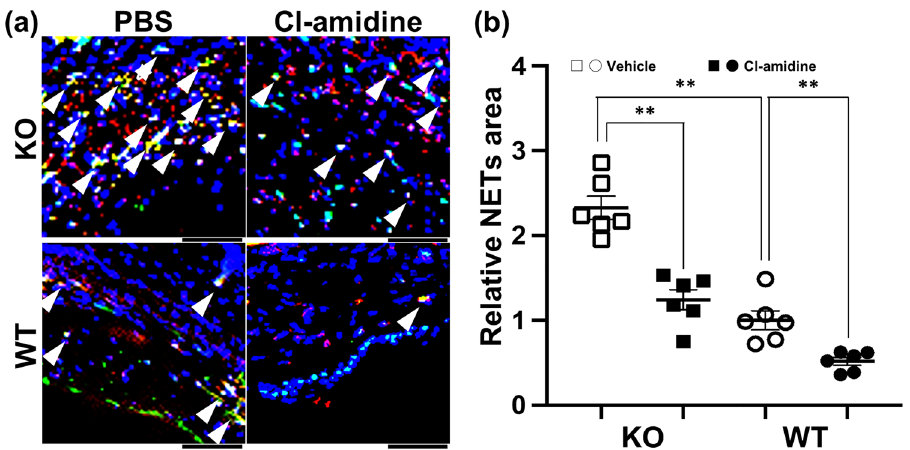
Figure 3. The effect of Cl-amidine on neutrophil extracellular trap (NET) formation during the contact hypersensitivity response in wild-type mice (WT) and Il36rn −/− mice (KO). ( a ) Representative immunofluorescence image of NET structures. Arrow heads show the formation NETs that were myeloperoxidase-positive (red) and citrullinated histone-positive (green). The nuclei were counterstained with 4’,6-diamidino-2-phenylindole (DAPI; blue). Scale bar = 50 μm. ( b ) The area of NETs was measured using the ImageJ software. Each histogram shows the relative area of NETs at 48 h after the DNFB challenge. All values represent the mean ± SEM obtained from six mice per group (** p <